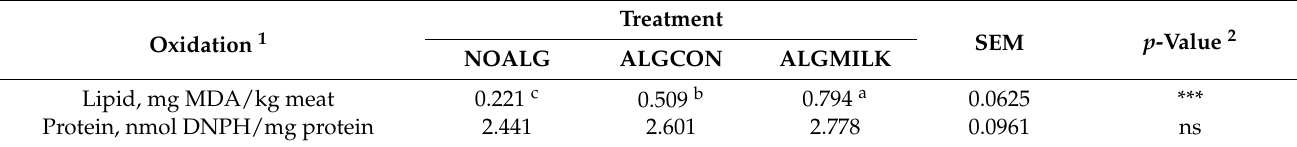
Table 1. Lipid and protein oxidation in meat from lambs fed a control diet (NOALG) and lambs with competent reticular groove reflex fed the control diet supplemented with 2.5% of marine algae meal mixed in the concentrate (ALGCON) or in a milk replacer (ALGMILK). Treatment SEM p -Value 2 Oxidation 1 NOALG ALGCON